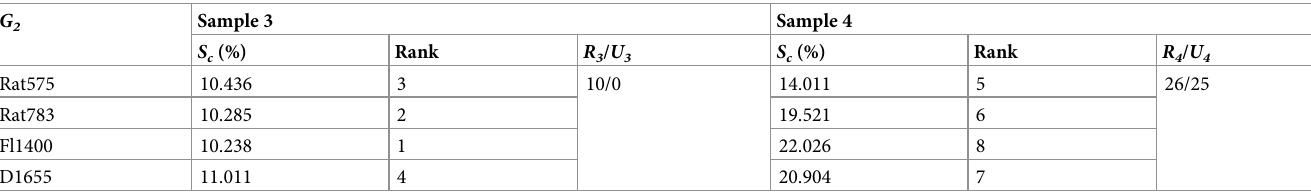
Table 5. S and rank of DSRABSQL and VDWOA algorithm in G c G 2 Sample